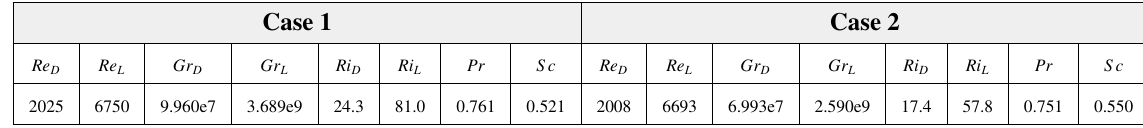
Table 1. Evaluated dimensionless numbers significant for mixed convection heat and mass transfer for both investigated